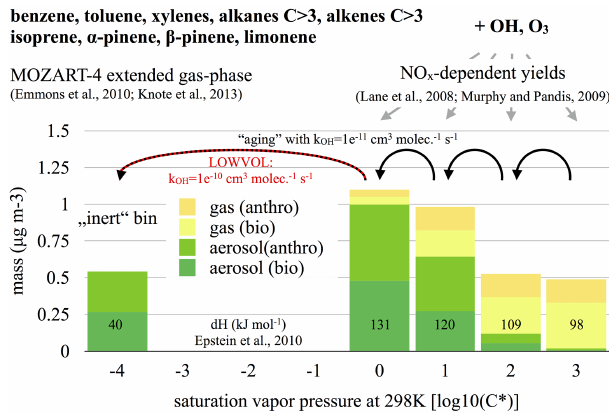
Figure 1. Schematic overview of the volatility basis set as imple- mented in WRF-Chem. SOA / SVOC values are surface level con- centrations from the REF simulation averaged over the full year 2010 and the CONUS domain (land points